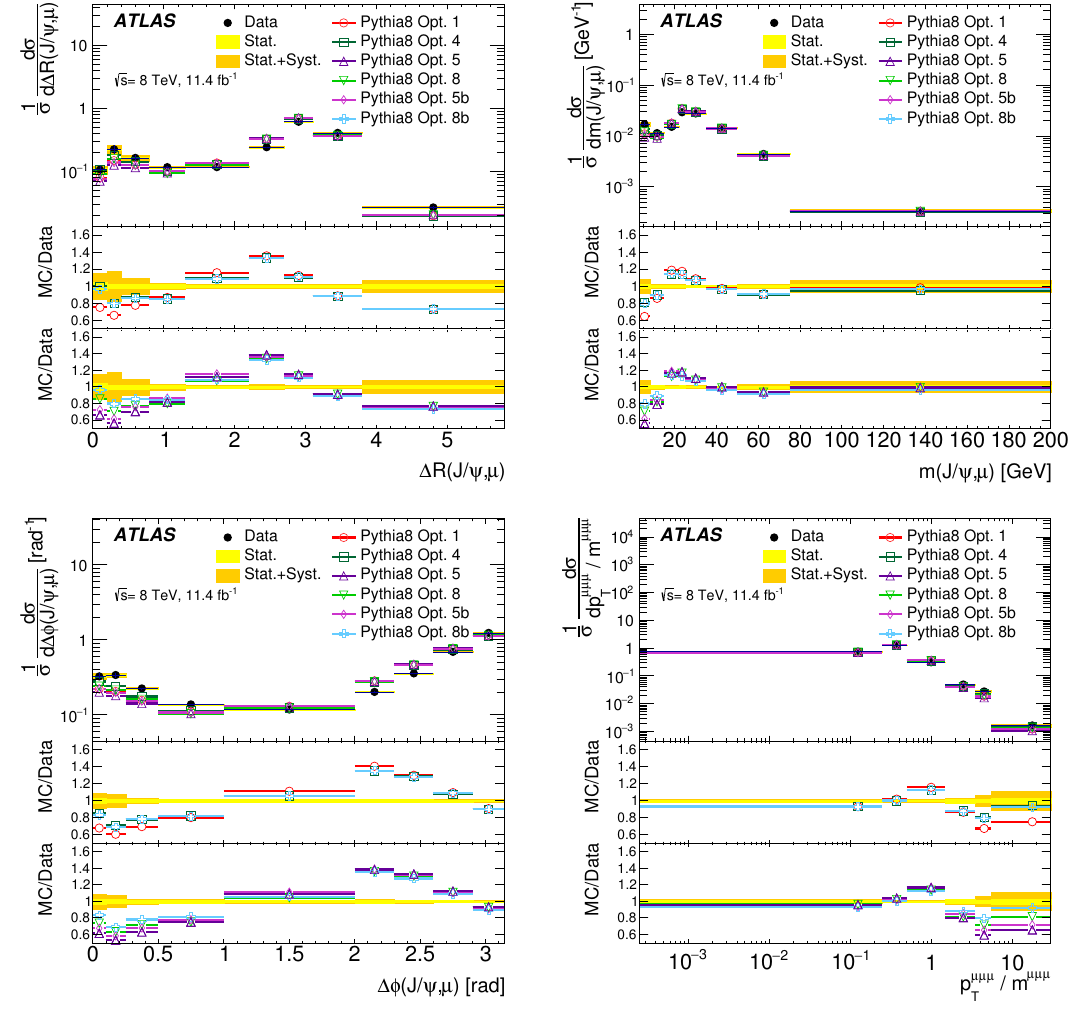
Figure 6 . Measured normalised di(cid:11)erential cross sections as a function of (cid:1) R ( J= ; (cid:22) ), m ( J= ; (cid:22) ), (cid:1) (cid:30) ( J= ; (cid:22) ) and p T =m compared to Pythia8 predictions with the di(cid:11)erent gluon-splitting param- eter settings described in table 1. The bottom pane shows the ratio to data of the options that use a mass-based splitting scale. The middle pane shows the p T -based scale options, along with the mass-based option that agrees best with data (Opt. 8b) for